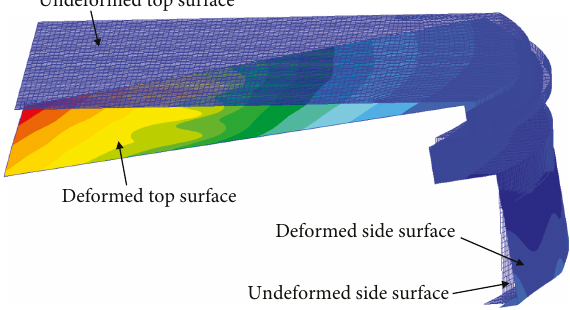
Figure 21: First modal deformation of the top surface and side surface of the inertial